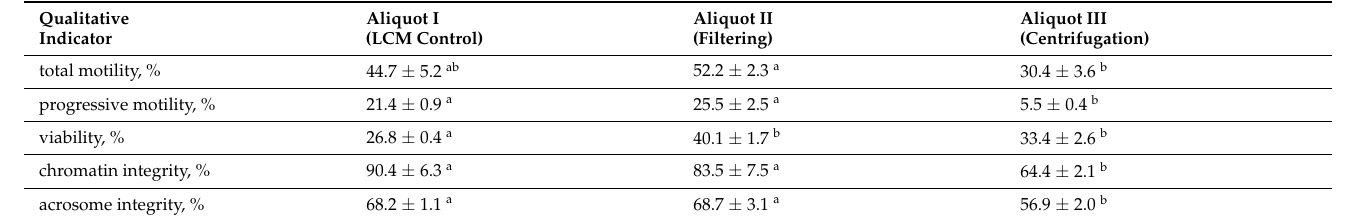
Table 3. The results of the assessment of frozen/thawed semen under the influence of technological factors (Mean ±SEM).